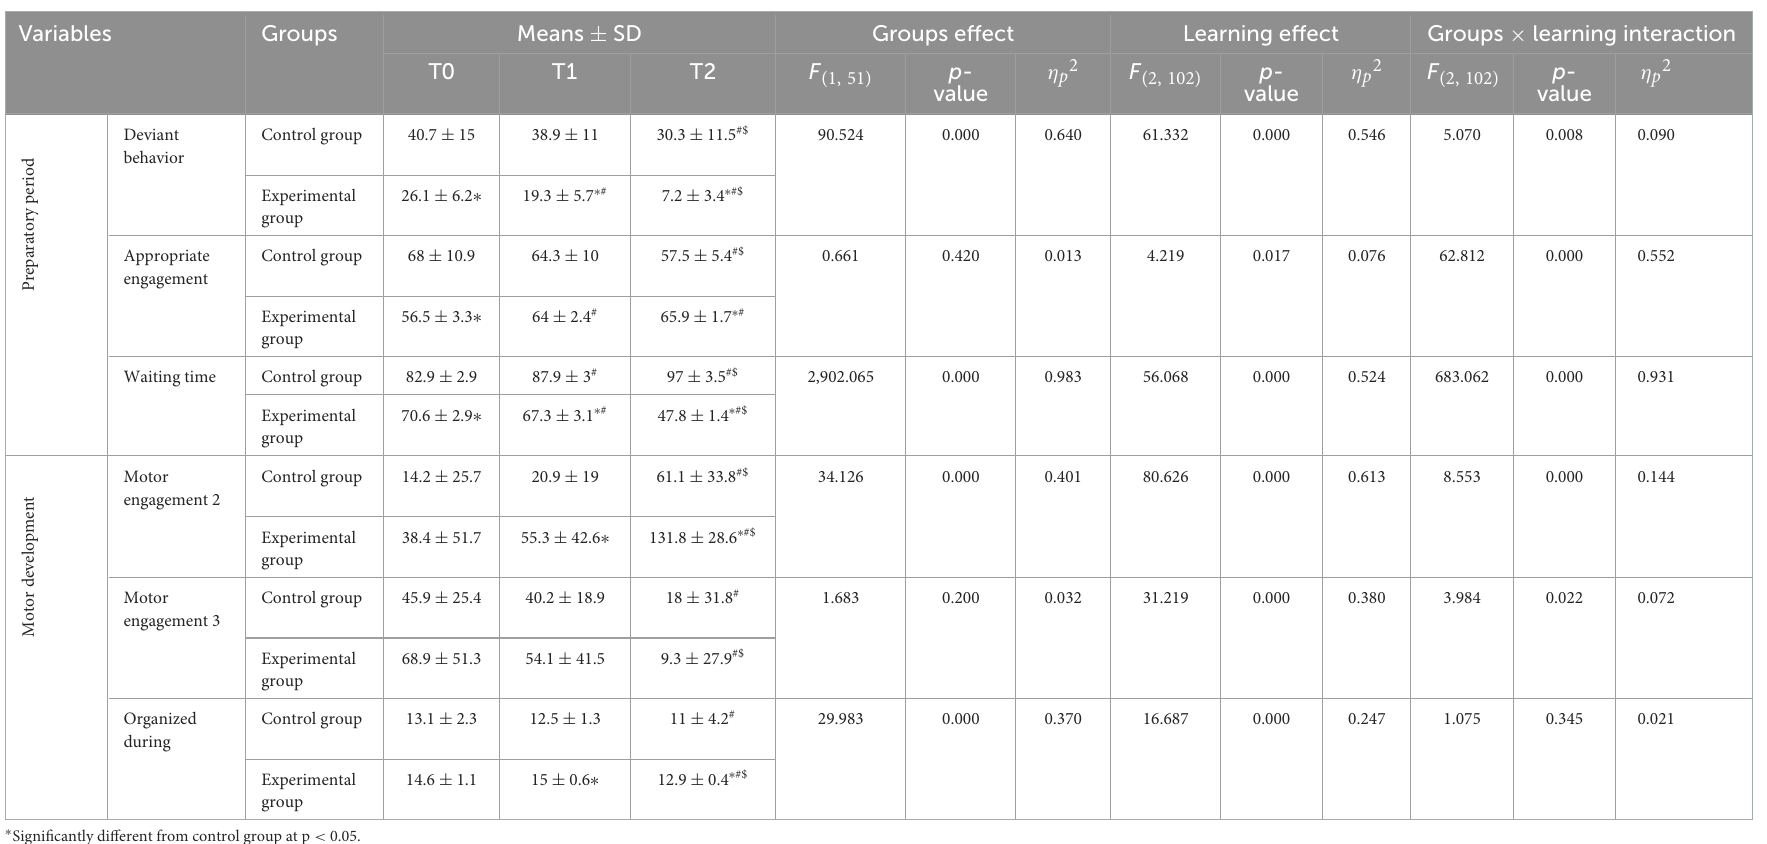
TABLE 2 Comparison of learning variables using two teaching methods in physical